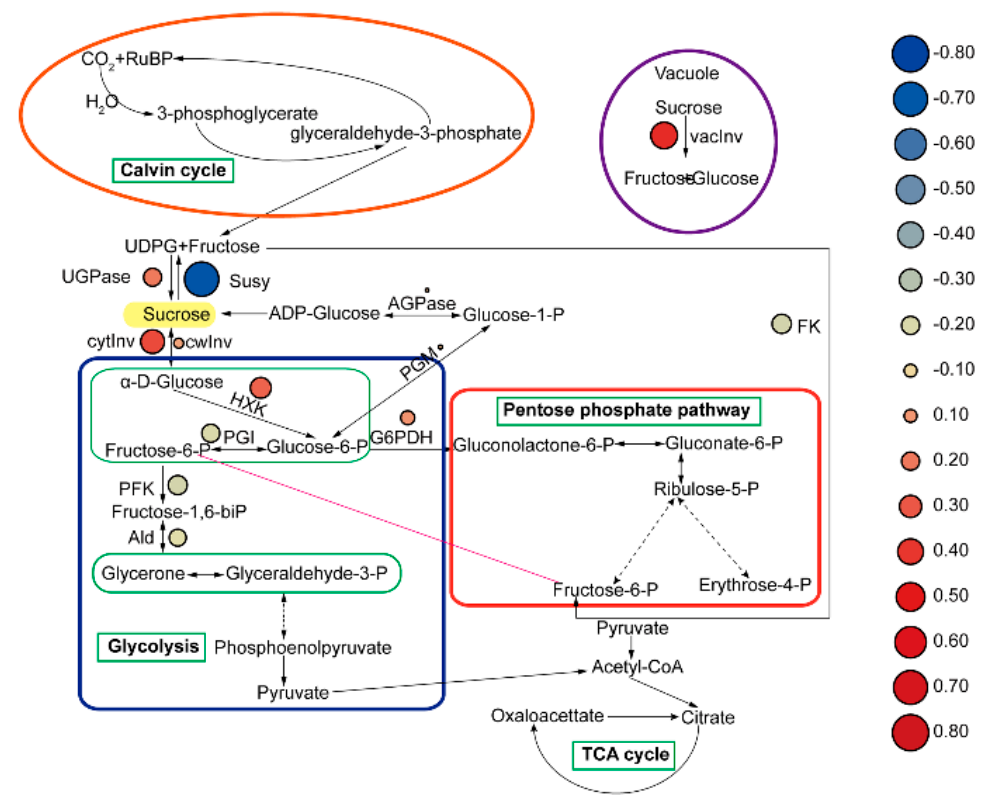
Figure 5. Heat map of activities of key carbohydrate metabolism enzymes in the leaves of Phragmites australis under control (CK) and melatonin (MT) conditions. Ald, aldolase; UGPase, UDP-glucose pyrophosphorylase; Susy, sucrose synthase; AGPase, ADP-glucose pyrophosphorylase; HXK, hexokinase; PGI, phosphoglucomutase; G6PDH, glucose-6-phosphate dehydrogenase; PFK, phosphofructokinase; PGM, phosphoglucomutase; FK, fructokinase; vacInv, vacuolar invertase; cytInv, cytoplasmic invertase; cwInv, cell wall invertase. The difference of activity for a given enzyme among these treatments is deviation standardization and converted to a circle. Circles indicates log2 fold change (MT/CK).